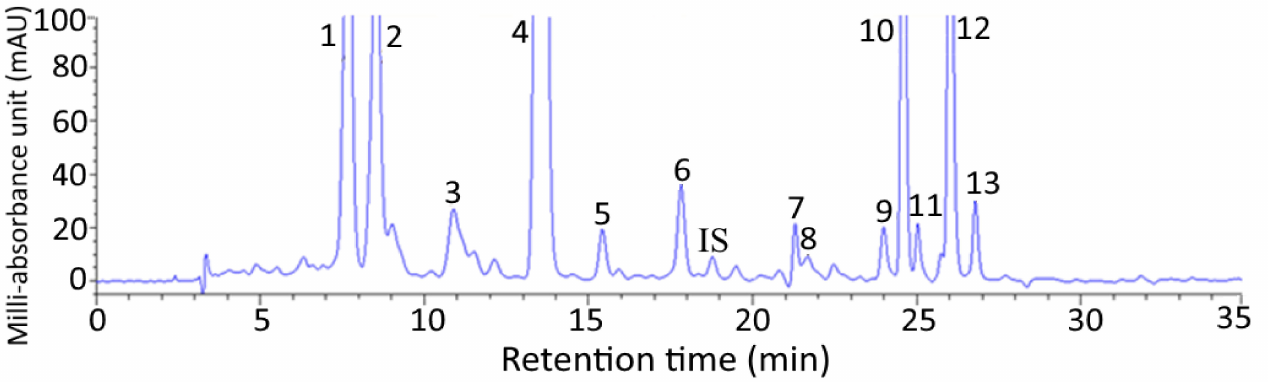
Figure 1. HPLC chromatogram of carotenoids isolated from pomelo leaves by using a C 30 column and mobile phase of methanol-acetonitrile-water (84:14:2, v / v / v ) (A), methylene chloride (B) with the following condition: 100% A in the beginning, decreased to 88% A in 2 min, 86% A in 8 min, 77% A in 14 min, 70% A in 19 min, 60% A in 21 min, 60% A in 24 min, 55% A in 34 min and finally 0% A in 38 min with flow rate at 1 mL/min and detection wavelength at 450 nm. Peak identification and quantification data are shown in Table